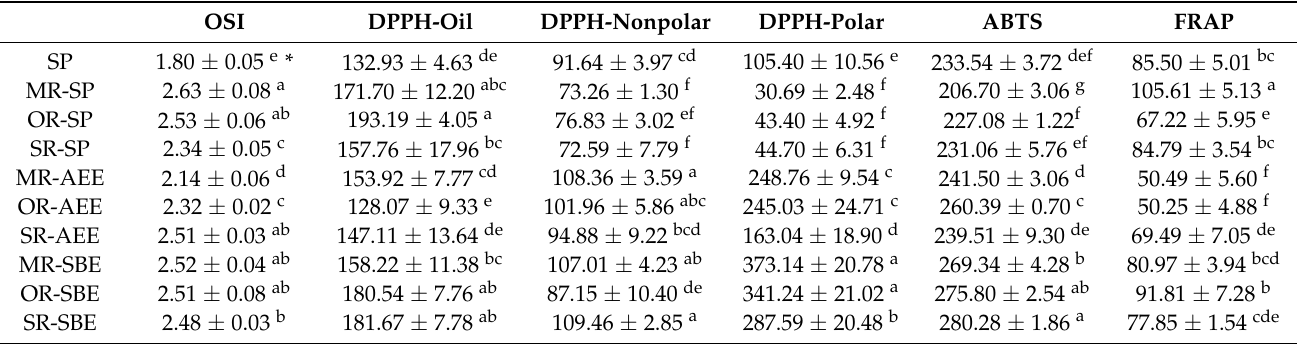
Table 3. Oxidation stability indexes (h) and free radical scavenging capacities ( µ mol TE /kg) of walnut